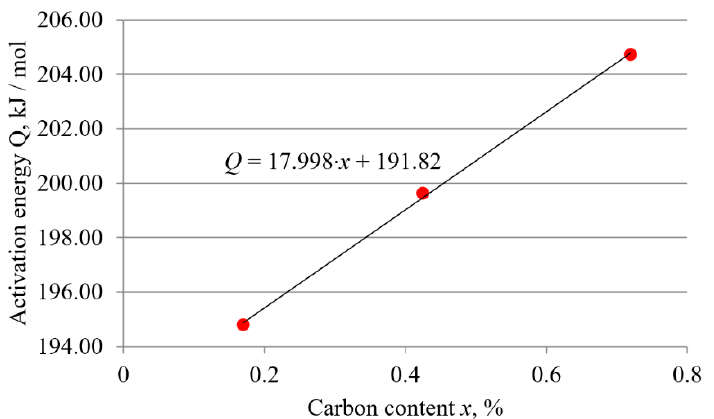
Figure 9. Relationship between the activation energy and the carbon content of steel.